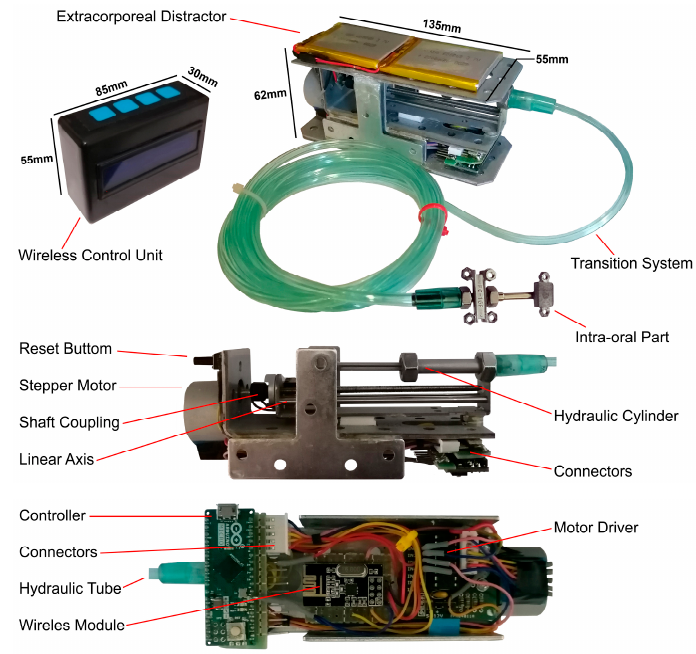
Figure 6. The first prototype of the hybrid distractor.